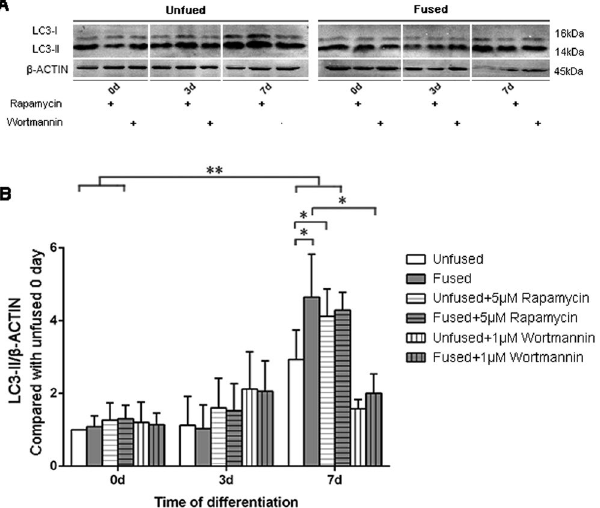
Figure 4. Effect of rapamycin or wortmannin on autophagic induction during cranial SMC differentiation. ( A ) Representative western blot of fused and unfused SMCs treated with or without rapamycin or wortmannin at different differentiation time points. ( B ) Quantification of LC3 and β -actin expression level by densitometry. Full-length blots are presented in the Supplementary Fig. 3. Data are expressed as the mean ± SD of three independent experiments. * P < 0.05; ** P <